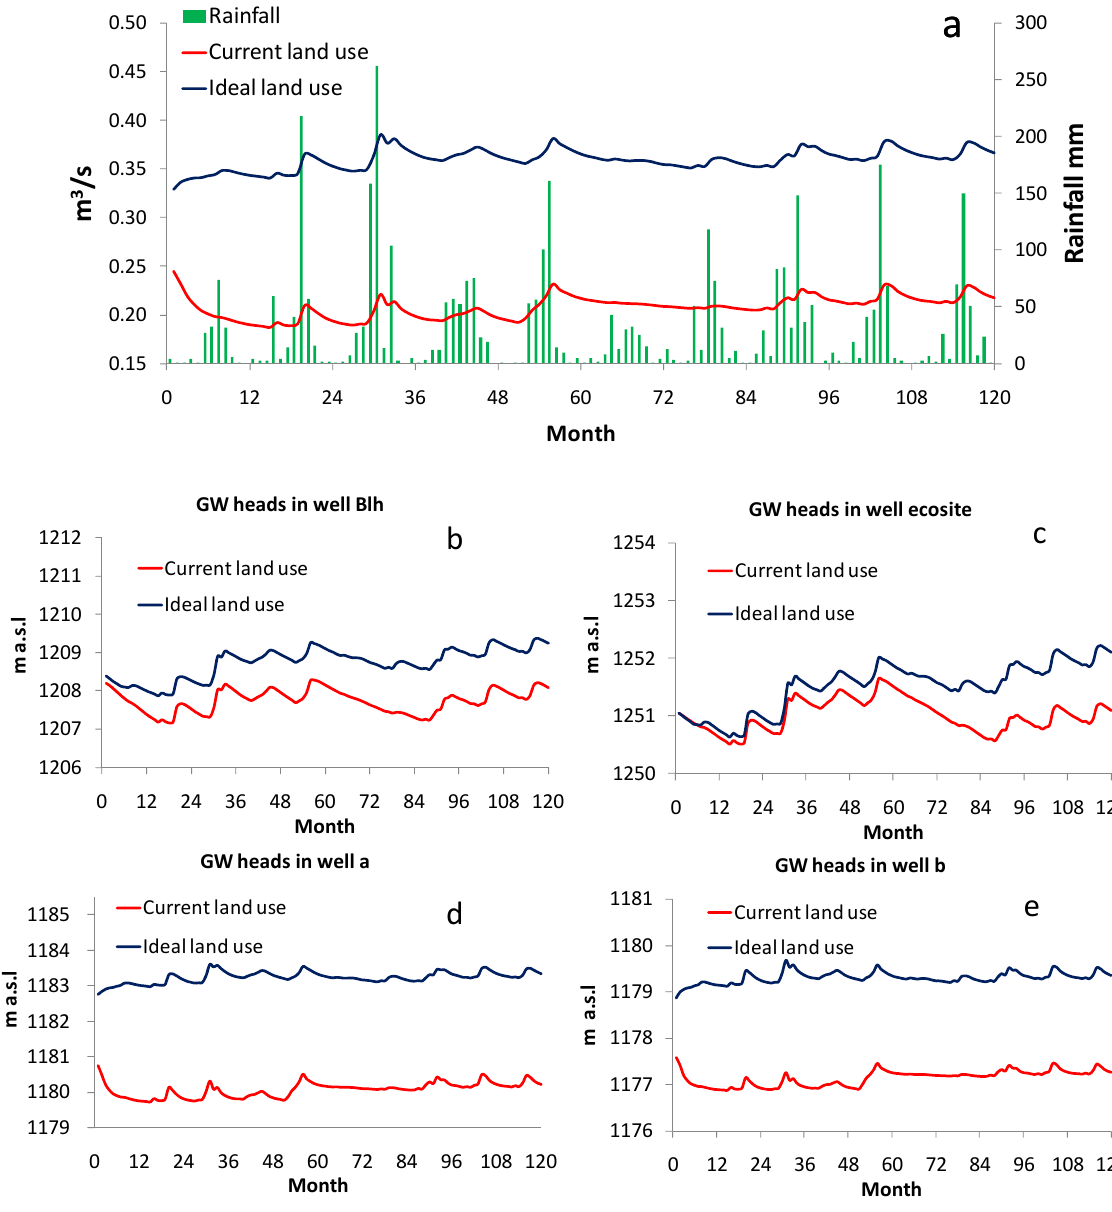
Figure 14. Simulated groundwater discharge to the Bulang River and the monthly rainfall at Wushenqi from 2000 to 2009 ( a ); the calculated groundwater heads in well Blh ( b ); eco_site ( c ); well a ( d ); and well b ( e ) for current and ideal land use scenarios from 2000 to